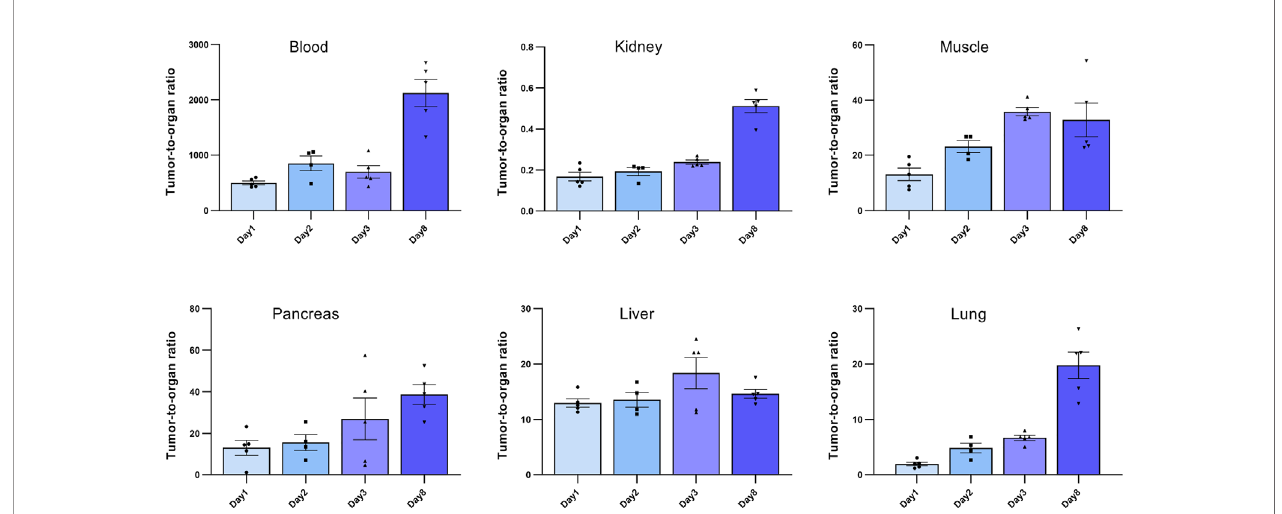
FIGURE 5 | Tumor-to-organ ratios of the 177 Lu-DOTA integrin a v b 6 knottin. Ratios to blood, kidney, muscle, pancreas, liver and lung were calculated using the ex vivo biodistribution values. Data represent mean ± S.E.M. (4 ≤ n ≤ 5).